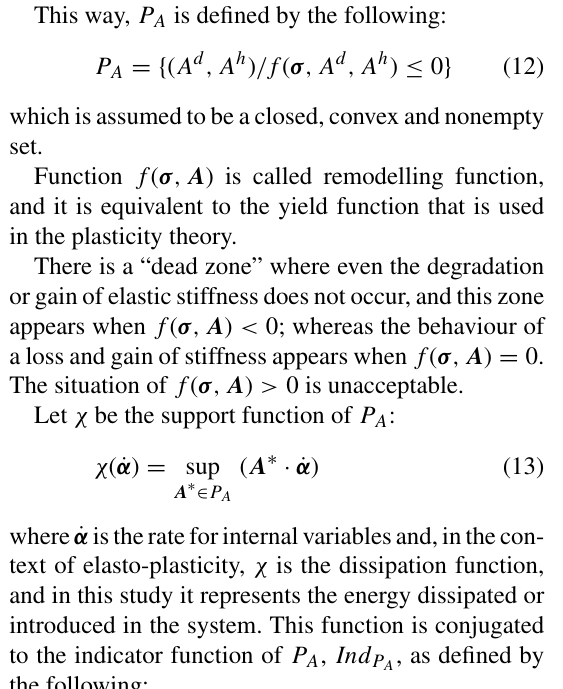
F.V. Tormena et al. / A bone remodelling model based on generalised thermodynamic potentials